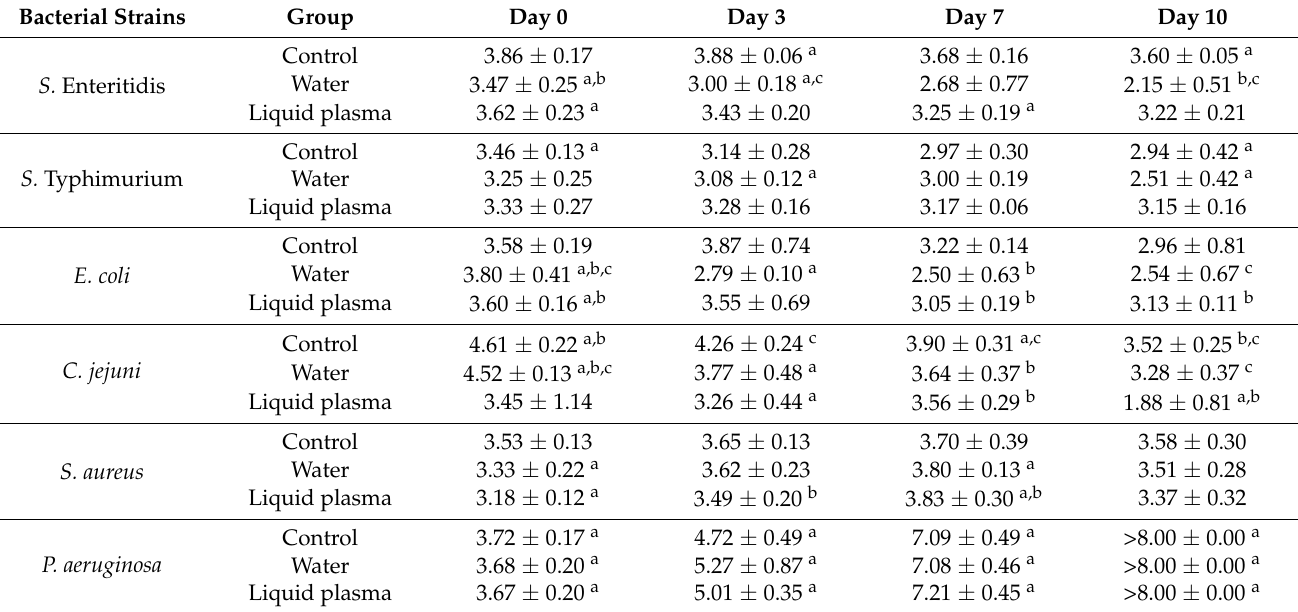
Table 3. Means of the microbial loads (log CFU/g ± SD) of pork samples at days 0, 3, 7, and 10 after being stored under refrigerated conditions.